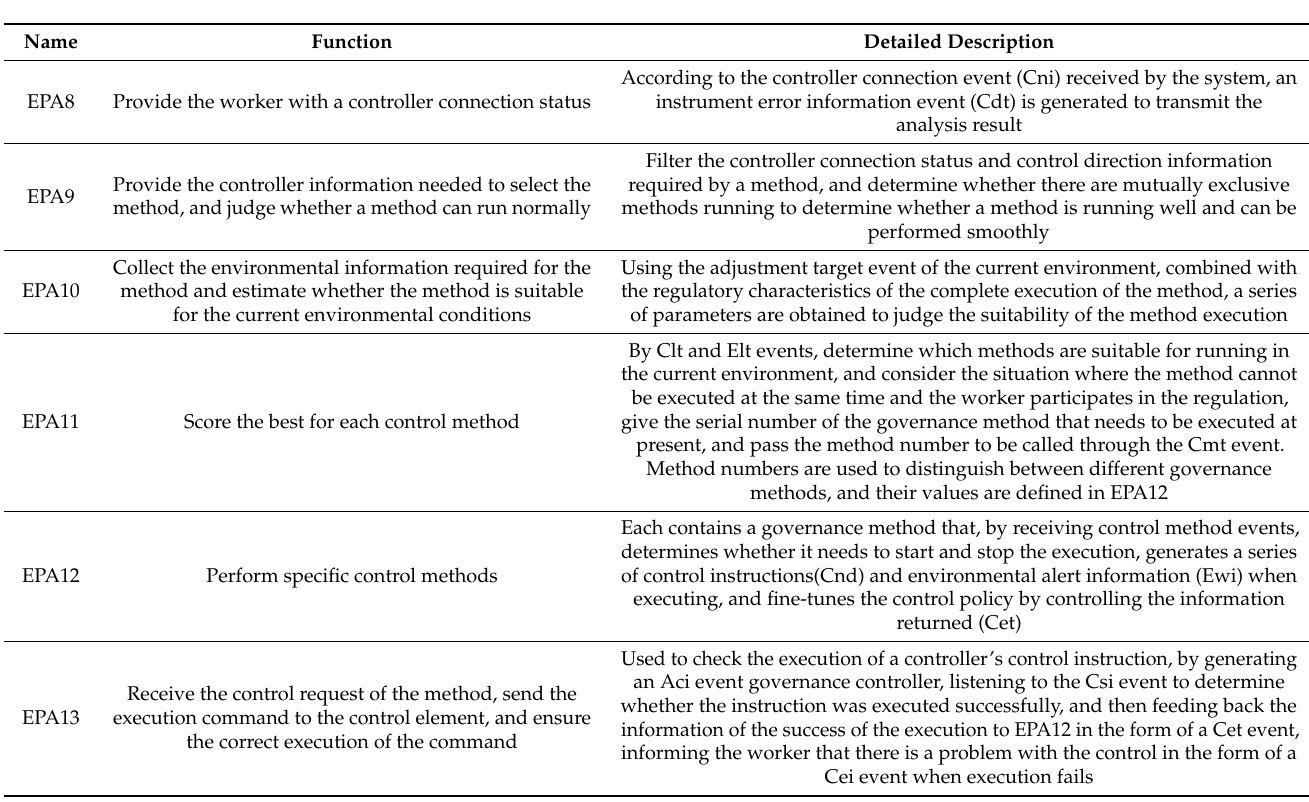
Table 5. EPA function Table